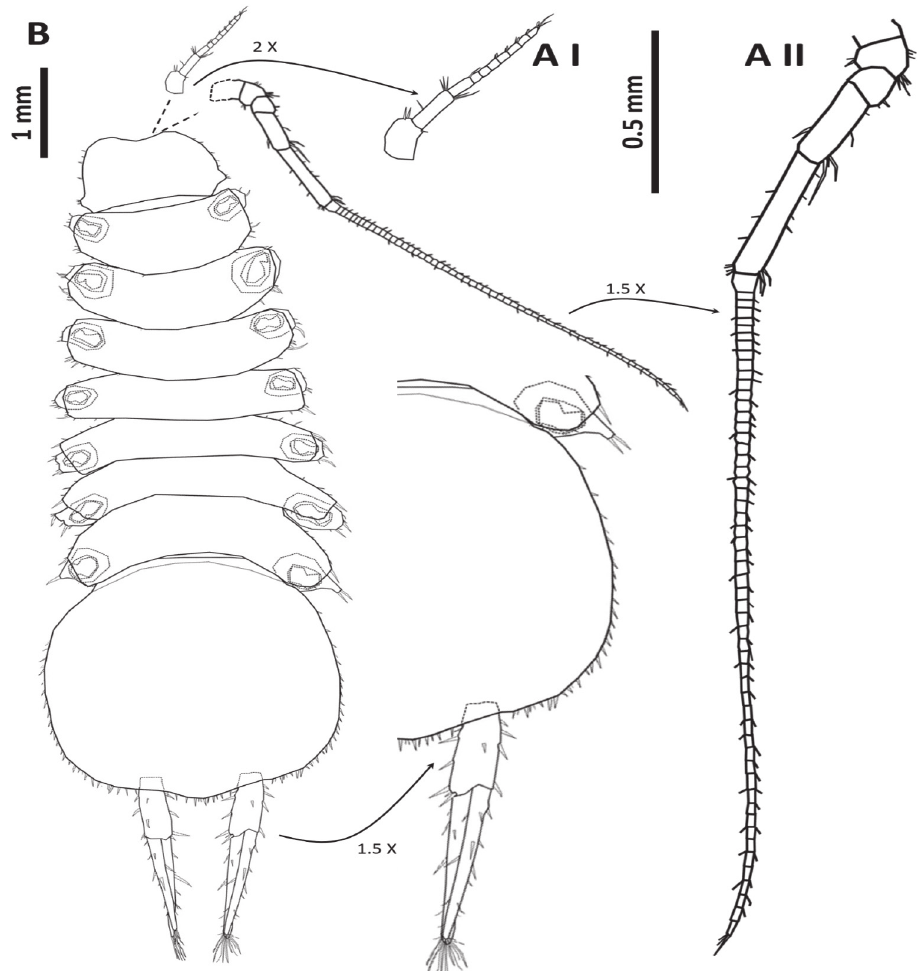
Figure 3. Asellus ismailsezarii sp. nov., Ganow spring, Western Iran. Holotype male, 8.2 mm: A I, II antennae I and II B body dorsal